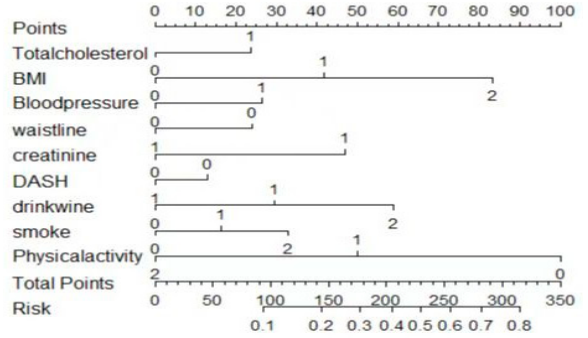
Figure 6. Nomogram of HUA prediction.